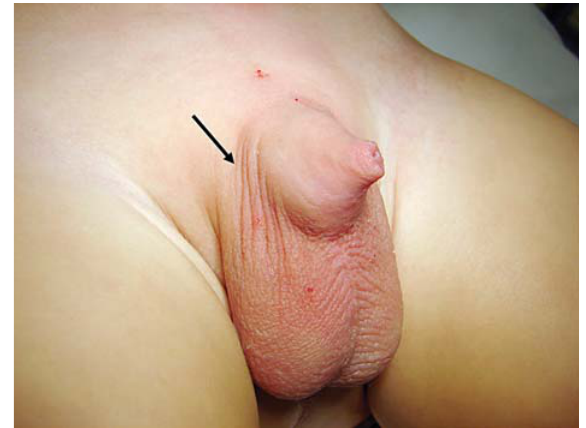
Figure 1 – The arrow shows an aspect of penoscrotal transposi- tion in a patient with megaprepuce.